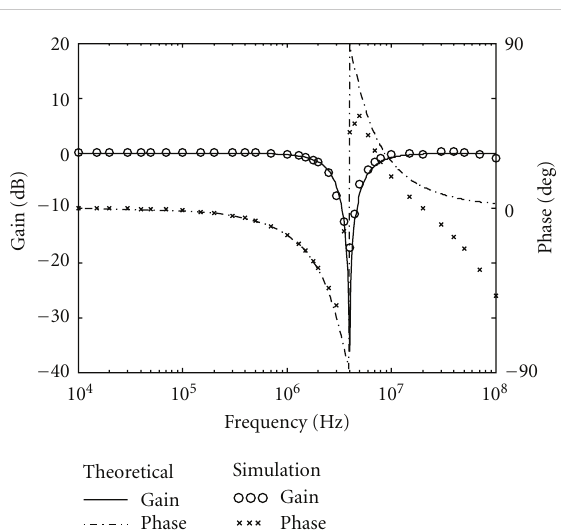
Figure 9: Simulation results of the proposed current-mode second- order notch